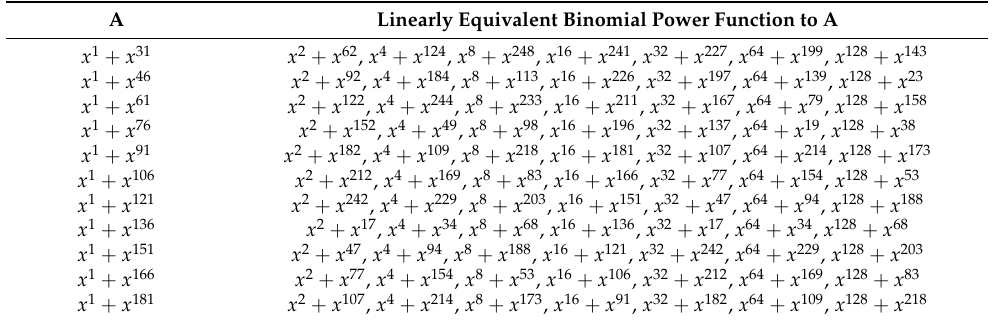
Table A1. Classification of Linearly Non-Equivalent Binomial Power Function with 15 to 1